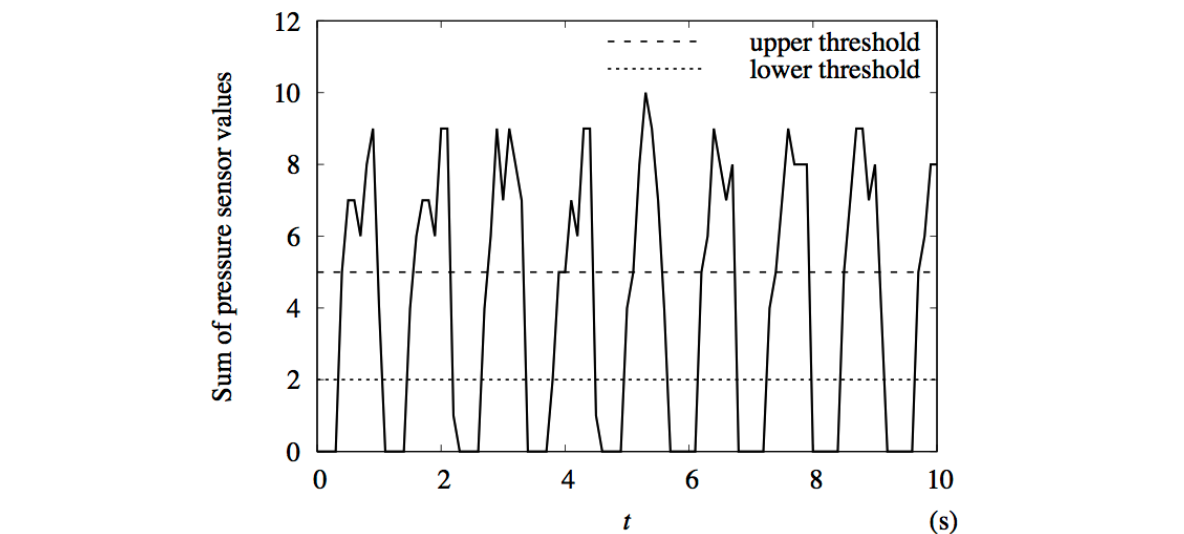
Figure 3. Graph of total pressure from the left foot sole over an interval of 10 seconds obtained from the foot monitoring system from the same data as presented in Figure 2. The two dashed lines indicate the upper and lower thresholds used to calculate the step